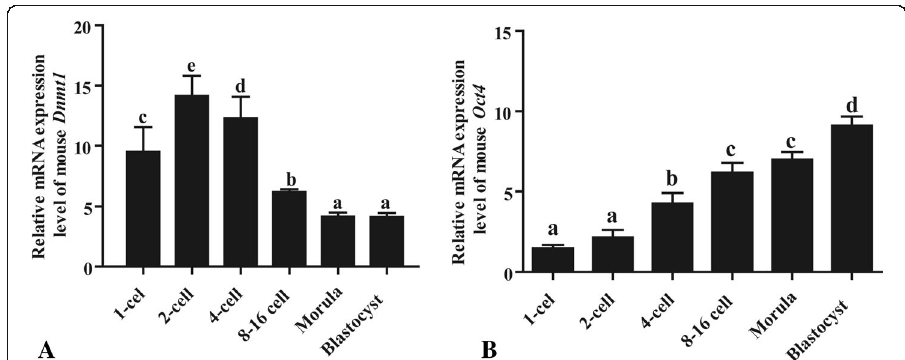
Fig. 1 The expression pattern of mouse Dnmt1 ( a ) and Oct4 ( b ) in pre-implantation embryos, as detected using real-time PCR. Data are expressed as the means ± SE of three replicates, and the values sharing the same letters are not significantly different at p <